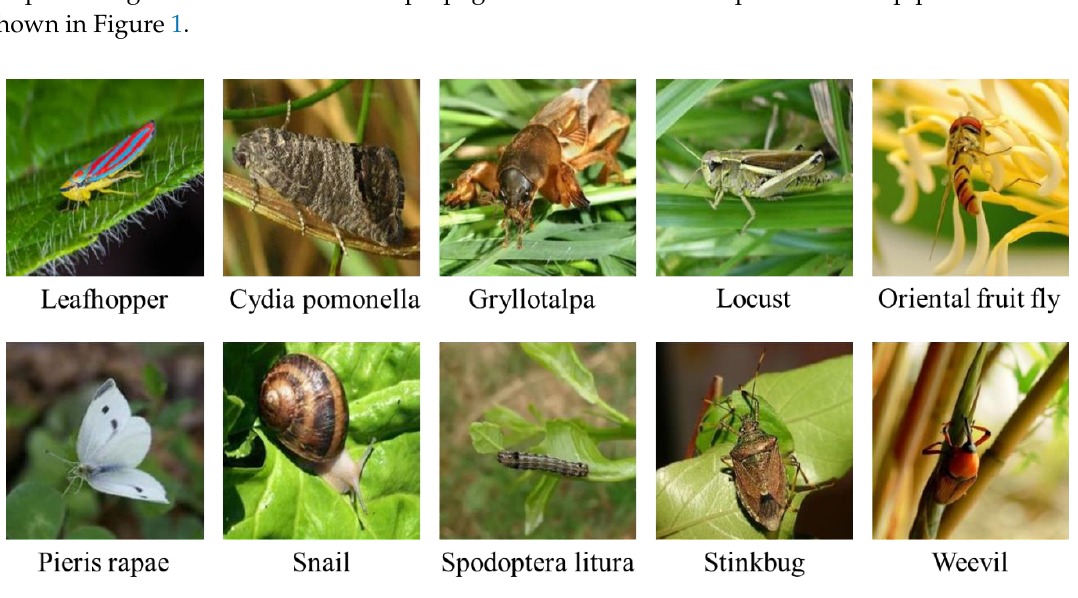
Figure 1. Samples of the crop pest dataset (from [26]).